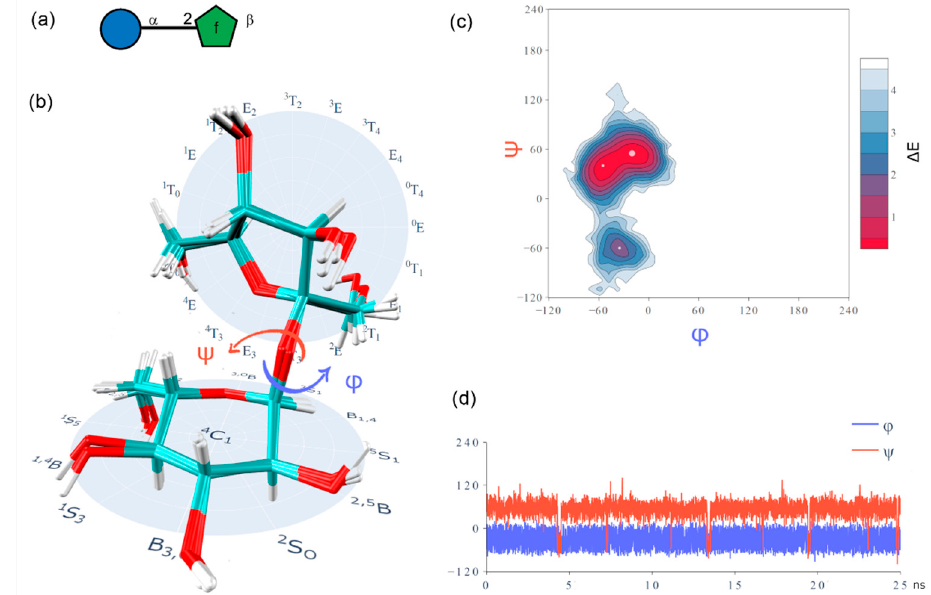
Figure 1. Typical components of a carbohydrate 3D structure exemplified on sucrose: ( a ) primary structure (in Symbol Nomenclature for Glycans (SNFG)); ( b ) superimposed conformational states and Cremer–Pople diagram; ( c ) conformational space of a two-torsion glycosidic linkage (Ramachandran plot); ( d ) transitions of glycosidic dihedrals.